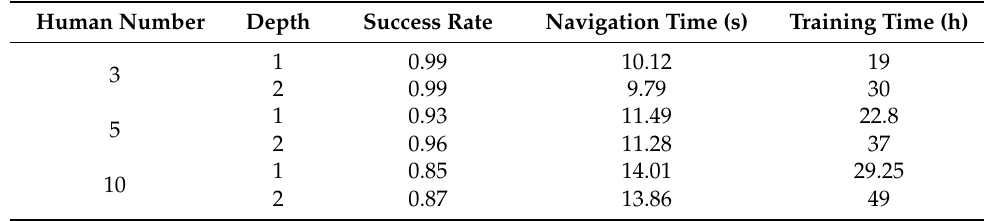
Table 3. Influence of Depth on navigation performance of